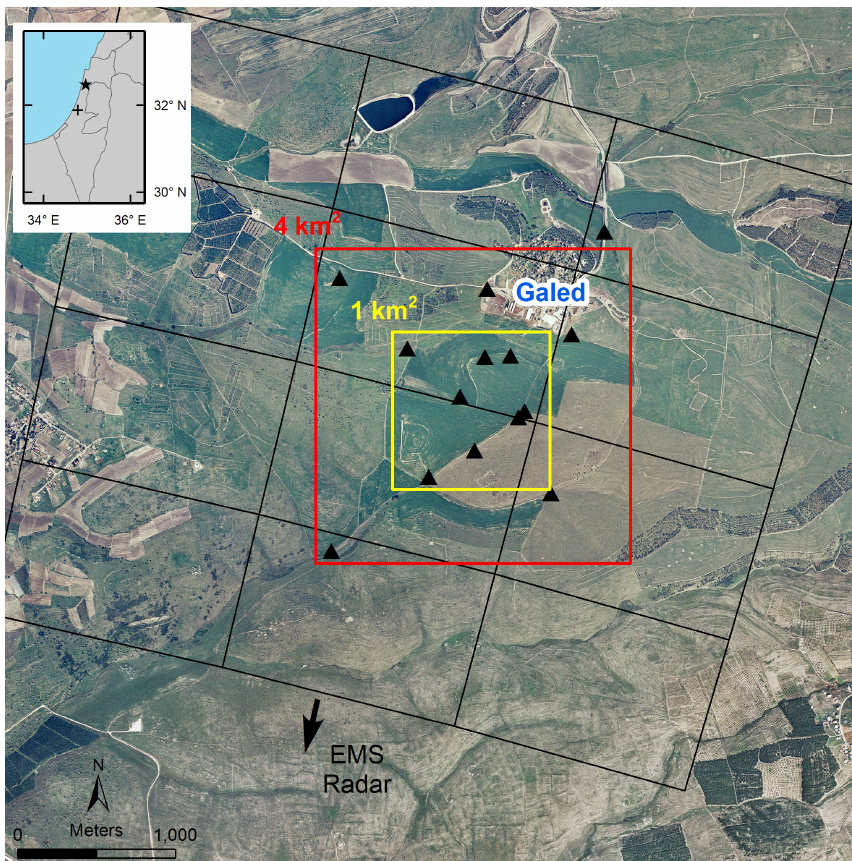
Fig. 1. Map of the study area including the 14 rain stations (triangles) around Kibbutz Galed. Each station is composed of two rain gauges. The black grid represents the radar mesh, with a spatial polar resolution of 1.4 ◦ × 1km. Inset shows the general location of the network in Israel (star) and the location of the EMS weather radar